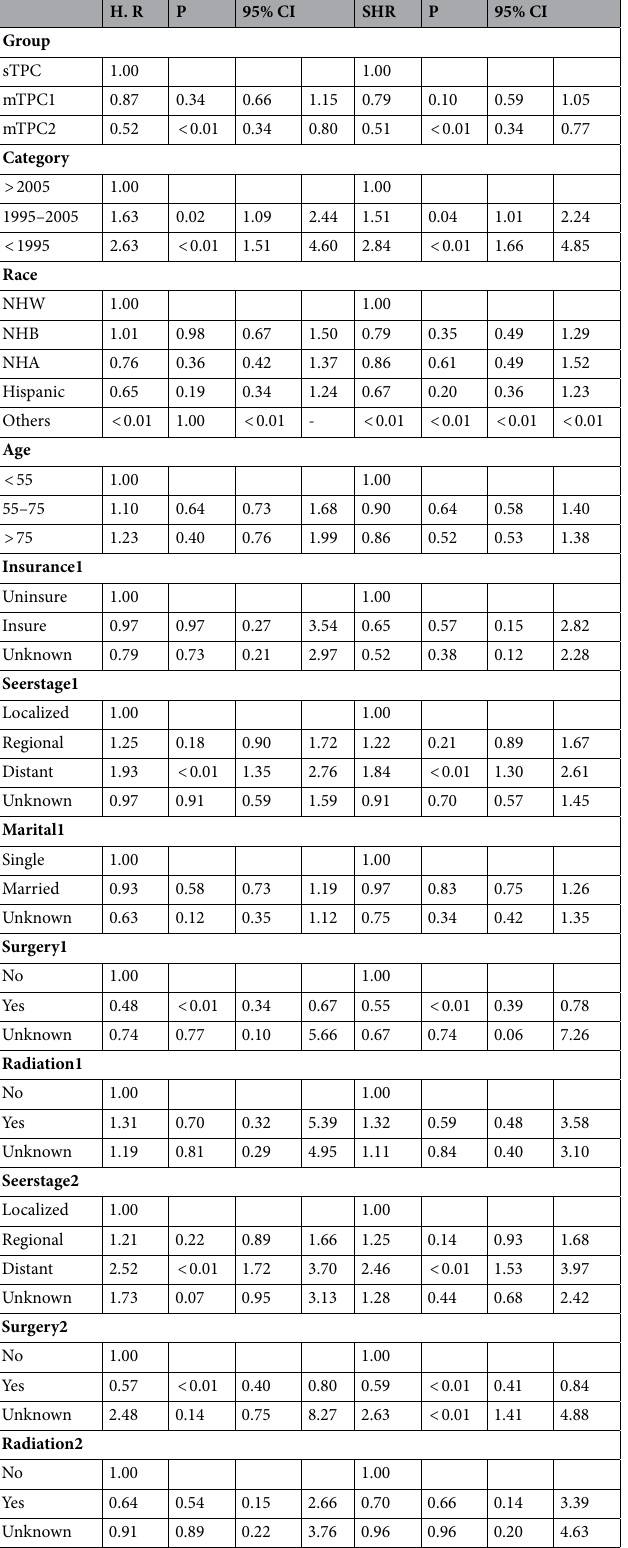
Table 6. Covariates associated with all-cause and cancer-specific death in patients with LABC. All variables were used in multivariate analysis. Insurance1 first insurance status; Seerstage1 first cancer stage; Surgery1 first surgery; Radiation1 first radiation; Seerstage2 secondary cancer stage; Surgery2 secondary surgery; Radiation2 secondary radiation; H.R risk of all-cause death; SHR risk of cancer-specific